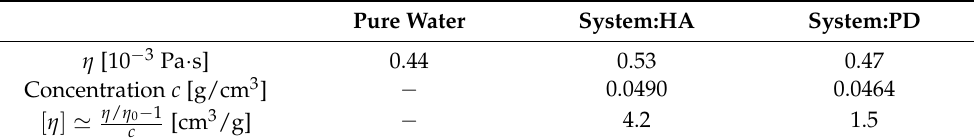
Table 3. Evaluated dynamic viscosity η and rough estimation of intrinsic viscosity [ η ] . Pure Water System:HA